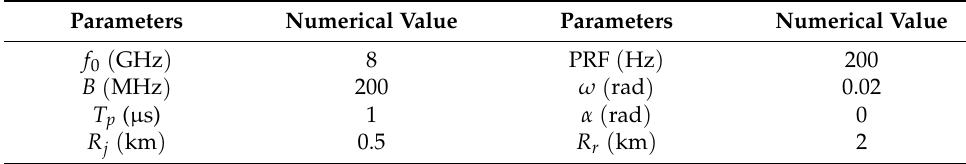
Table 1. Simulation parameters.